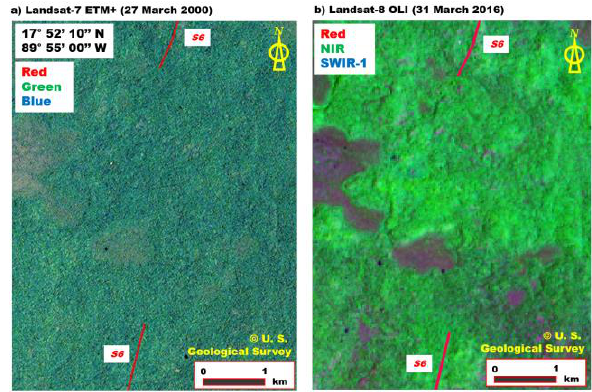
Figure 8. Gap between the two Sacbe #6 segments of Folan et al. (1995) located in a forested area, as displayed: a) on a Landsat-7 ETM+ true-colour composite (red band in red, green band in green, and blue band in blue) made with the image acquired in March 2000 and, b) a Landsat-8 OLI false-colour composite (red band in red, near-infrared band in green, and first shortwave infrared band in blue) made with the image acquired in March 2016.